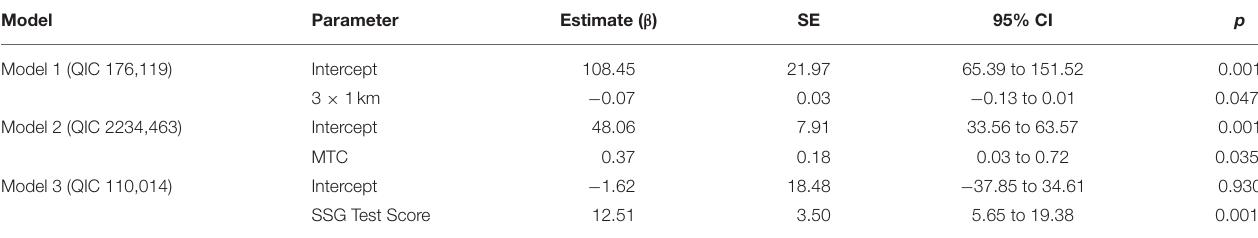
TABLE 1 | Univariate generalized estimating equations for prediction of disposal efficiency. Model